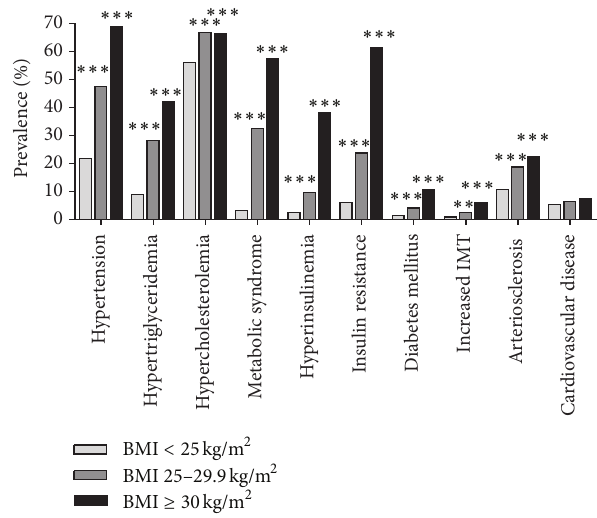
Figure 3: Prevalence of cardiometabolic diseases stratified by BMI. Differences statistically tested by overall likelihood ratio tests from logistic regression analysis ( ∗∗ 𝑃 < 0.01 ; ∗∗∗ 𝑃 < 0.001